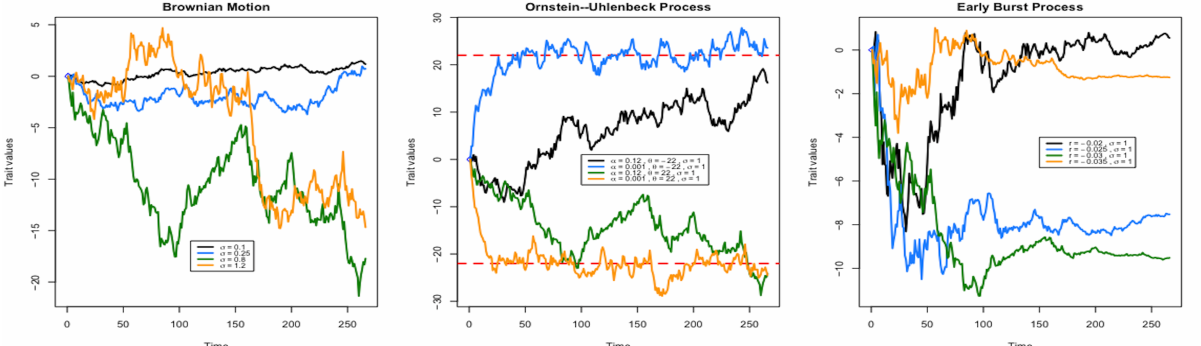
Figure 5. Left panel : Trajectories for the BM using four rates of evolution ( σ = 0.1,0.25,0.8, and 1.2). Middle panel : Trajectories for the OU using different two optima ( θ = − 22,22), α = 0.001,0.12, and σ = 1. Right panel : Trajectories for the EB model using four different rates ( r = − 0.02, − 0.025, − 0.03, − 0.035) with σ =